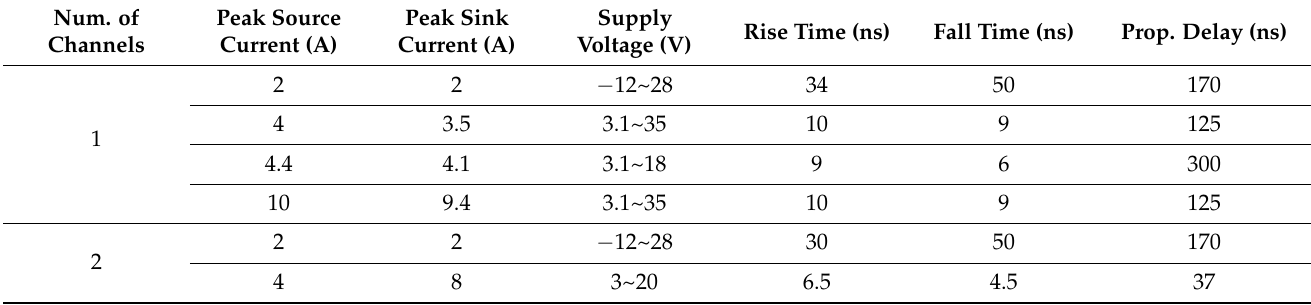
Table 29. Commercial SiC MOSFET drivers by Infineon Technologies.